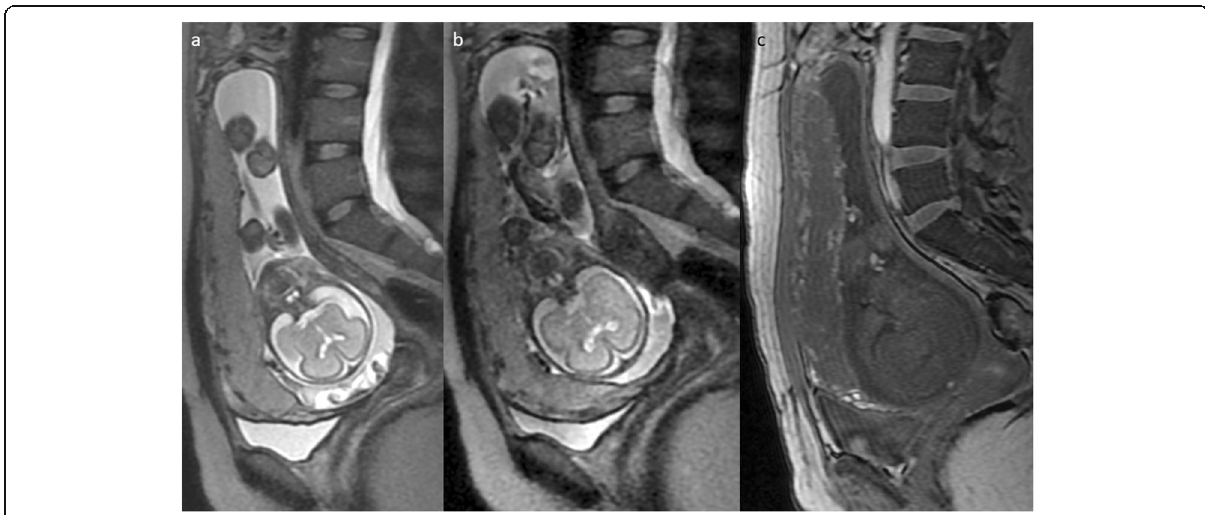
Fig. 15 A 32-year-old woman, 3rd pregnancy, 24 GW, history of a classical C-section 2 years ago and ectopic scar pregnancy 1 year ago. FIESTA/